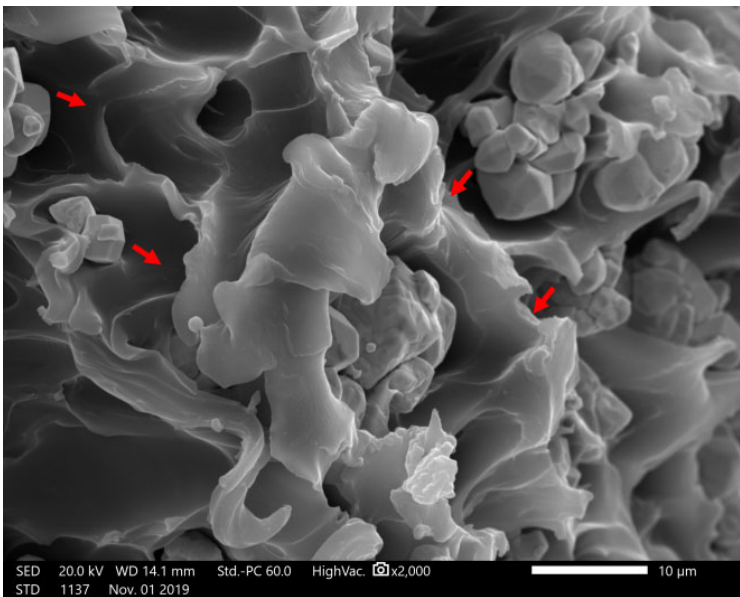
Figure 15. Electron micrograph of the fracture surface of 70% PEEK/tungsten composite (×2000).